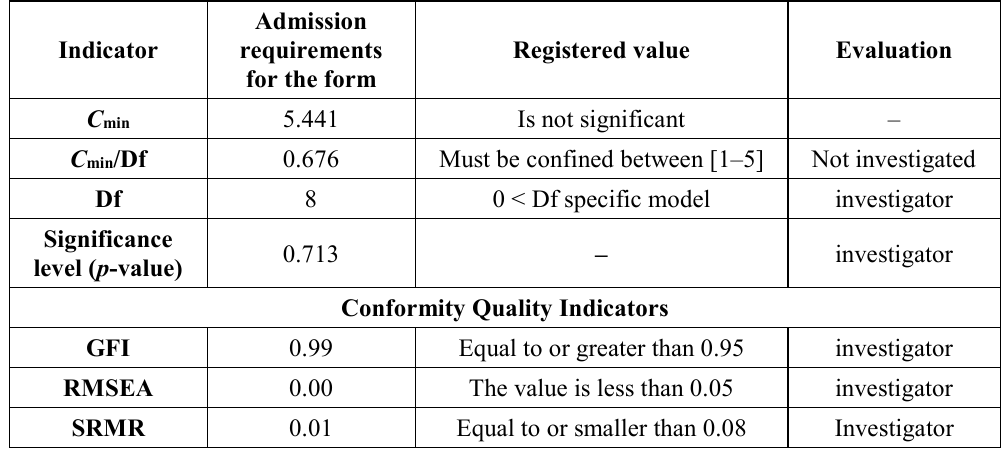
Table 8. Absolute Conformity Indicators of the Study